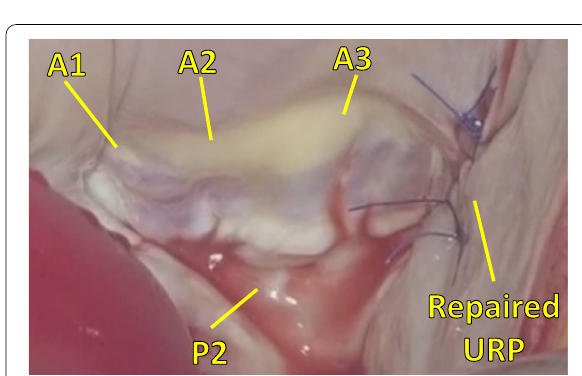
Fig. 4 Intraoperative photo showing completion of the unroofed portion repair. Intraoperative photo showing completion of repair of the unroofed portion by use of a direct running suture from the top and bottom edges. P2 P2 segment of posterior mitral leaflet, A1 A1 segment of anterior mitral leaflet, A2 A2 segment of anterior mitral leaflet, A3 A3 segment of anterior mitral leaflet, URP unroofed portion